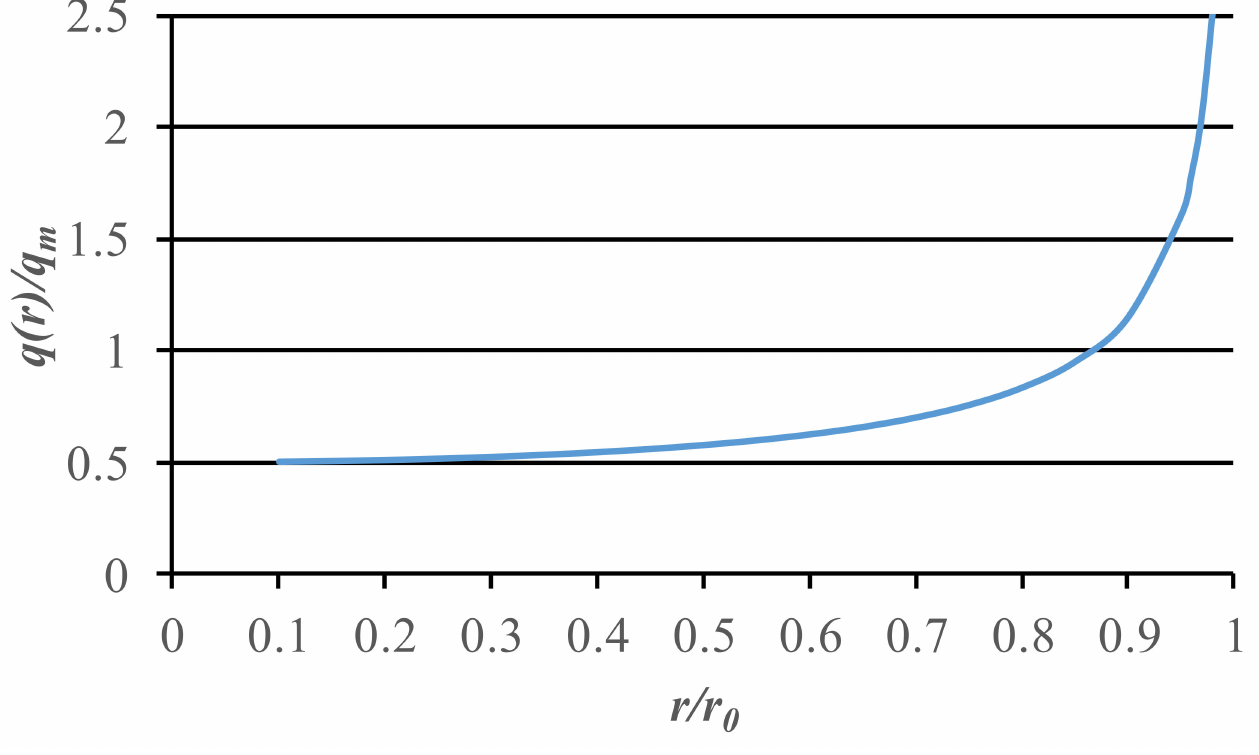
Figure 7. Flow distribution curve through the